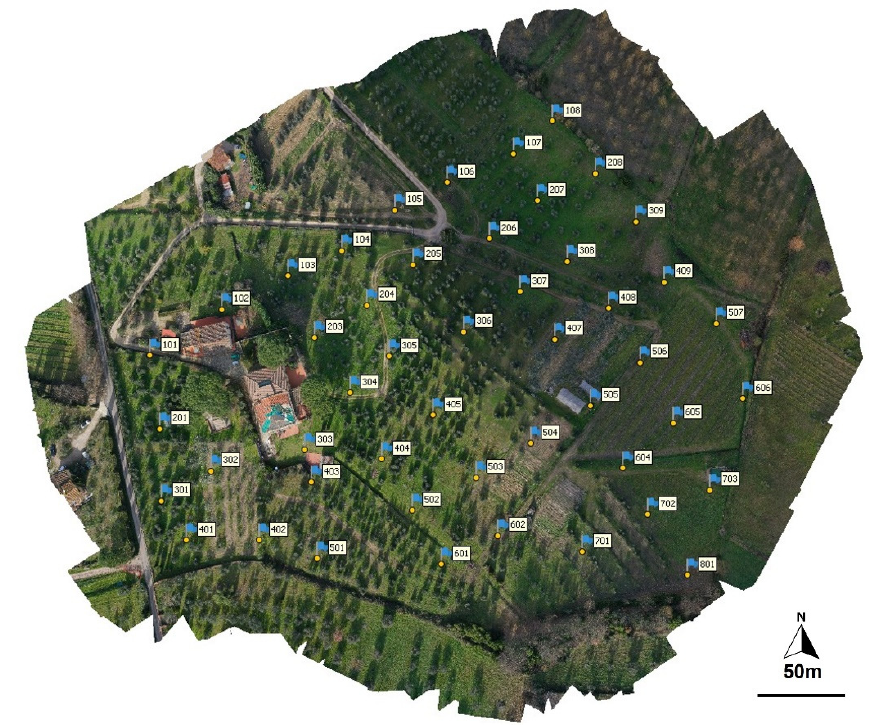
Figure 5. Sparse point cloud of the study area and GCP regular grid.